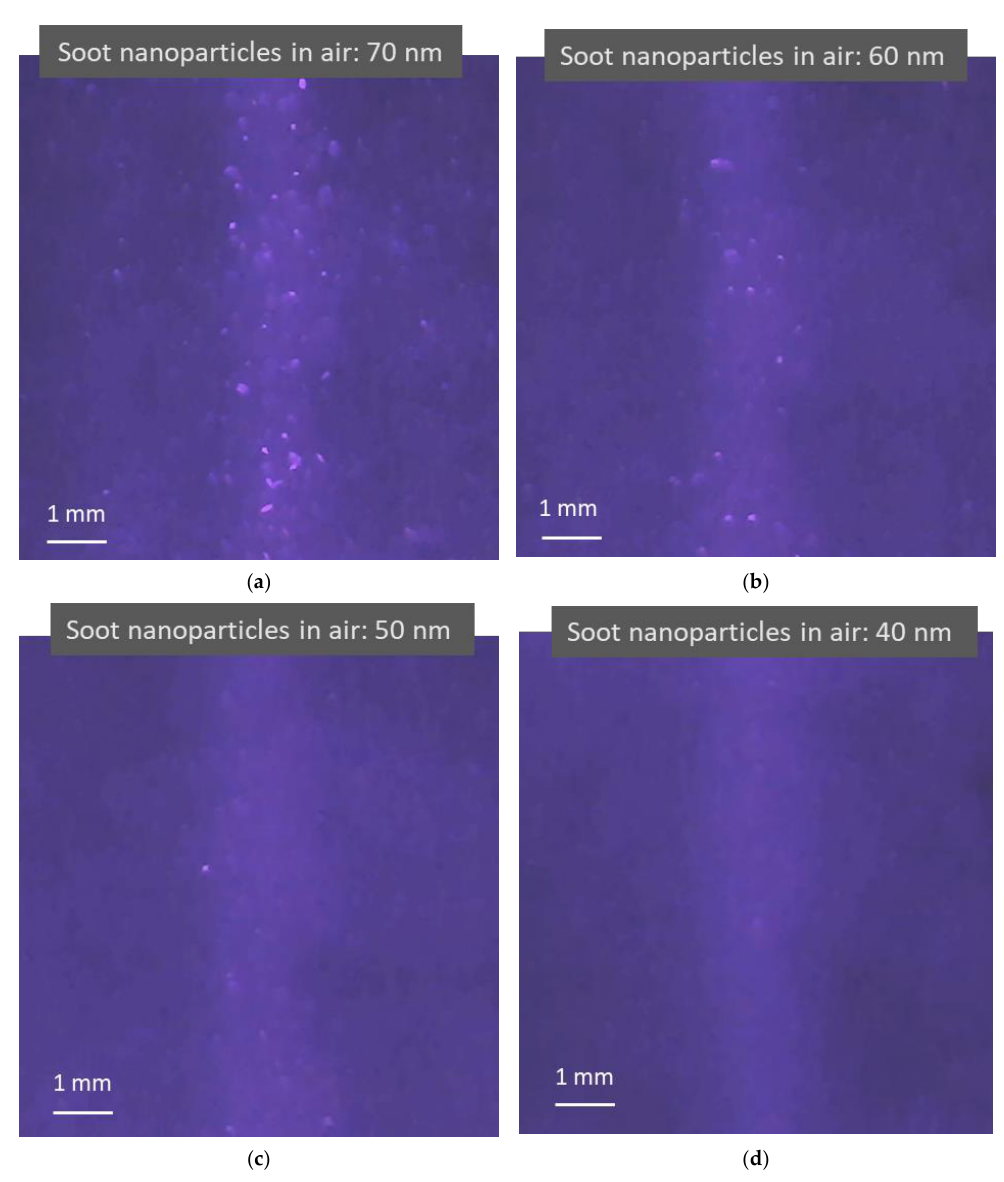
Figure 5. Images of light scattering captured in light scattering detection videos when irradiating air containing light-absorbing soot nanoparticles using a blue laser (λ = 450 nm). ( a – d ) Brighter blue images are formed from the particle light scattering of 70, 60, 50, and 40 nm soot nanoparticles and air molecule light scattering, respectively. The lighter blue background appears due to weak light reflections from the testing device surface. As the airborne nanoparticle size decreases, the particle light scattering images change from large bright dots to tiny darker dots mixed with air molecule light scattering.